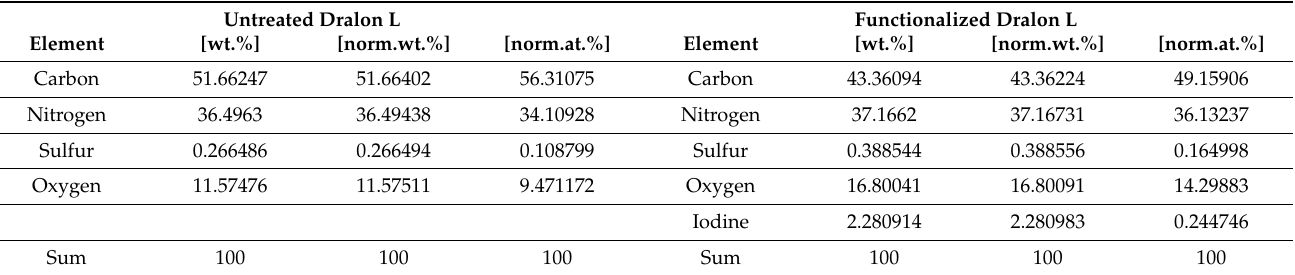
Table 5. Elemental composition of Dralon L fibers before and after functionalization.